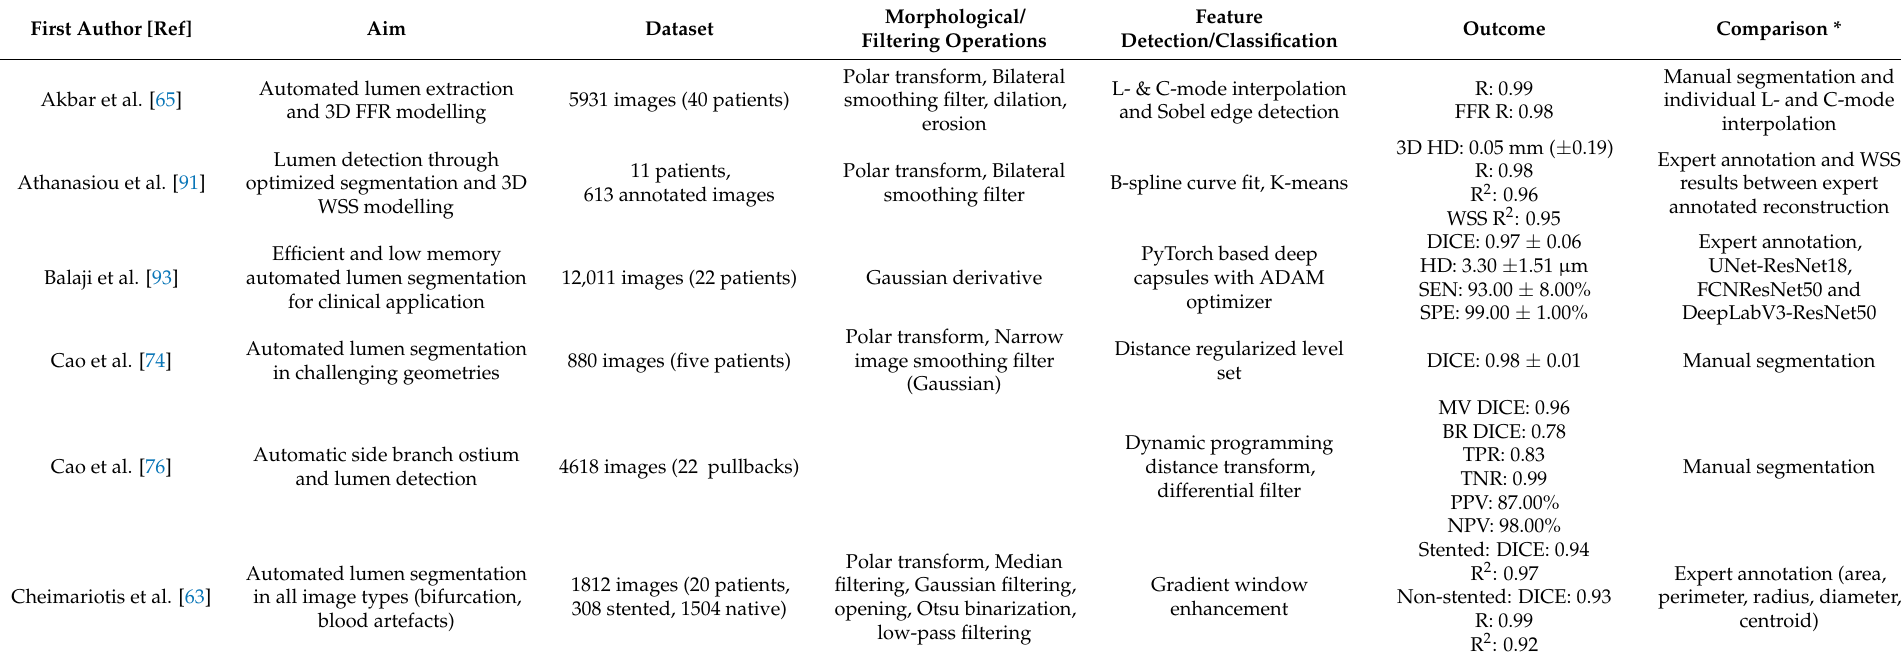
Table A1. Classified articles investigating automated coronary lumen segmentation. 3D—Three-dimensional. ACC—Accuracy. ADAM—Gradient based adaptive optimization. ASSD—Average symmetric surface distance. AUC—Area under the curve. BHAT—Bhattacharya distance. BR—Bifurcation region. CK—Cohen’s kappa coefficient. CNN—Convolutional neural network. DA—Data augmentation. DICE—Dice loss coefficient. FFR—Fractional flow reserve.